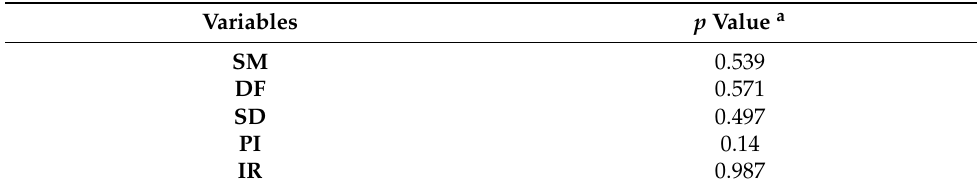
Table 3. Mann-Whitney U test calculations.